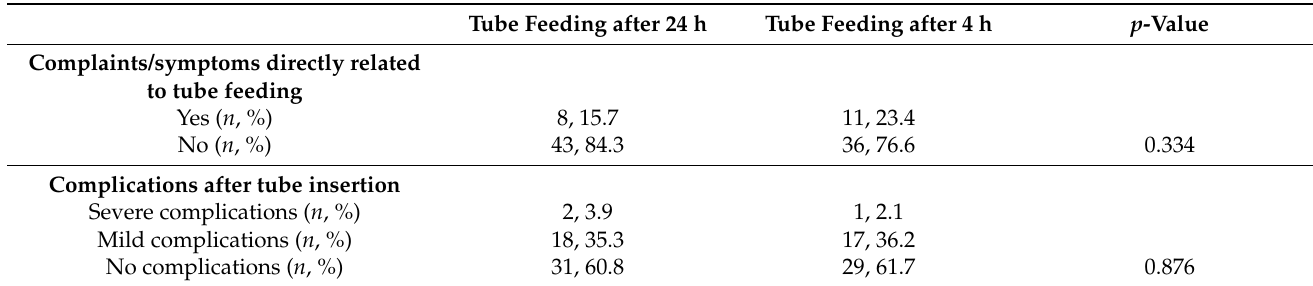
Table 1. Cont. Tube Feeding after 24 h Tube Feeding after 4 h p